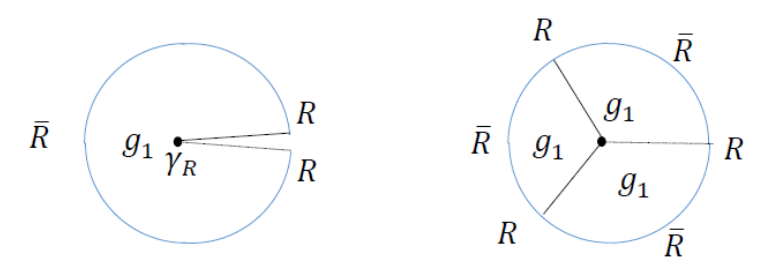
Figure 1 . After cutting open the n = 1 bulk saddle g 1 (left), three copies may be glued together to construct the n = 3 bulk saddle g 3 (right). The black dot in the center is the HRT surface (cid:13) R